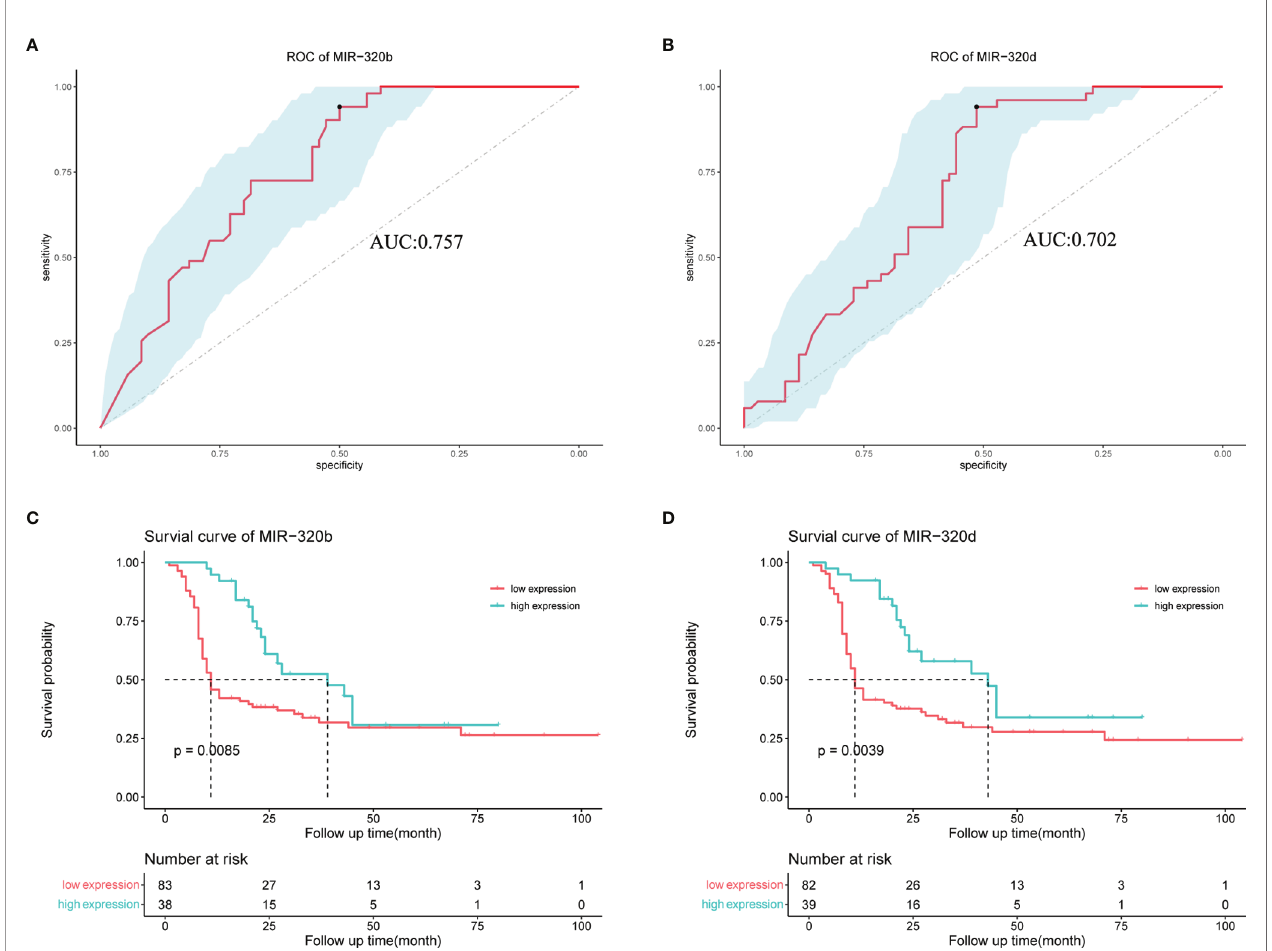
FIGURE 6 | Effect of miR-320b and miR-320d as biomarkers to predict platinum resistance and tumor recurrence in ovarian cancer patients receiving platinum- based chemotherapy by ROC and survival curves. (A, B) ROC curves of miR-320b and miR-320d. (C, D) Survival curves of high-expression group and low- expression group judged by expression levels of miR-320b and miR-320d, respectively. ROC curve, receiver operating characteristic